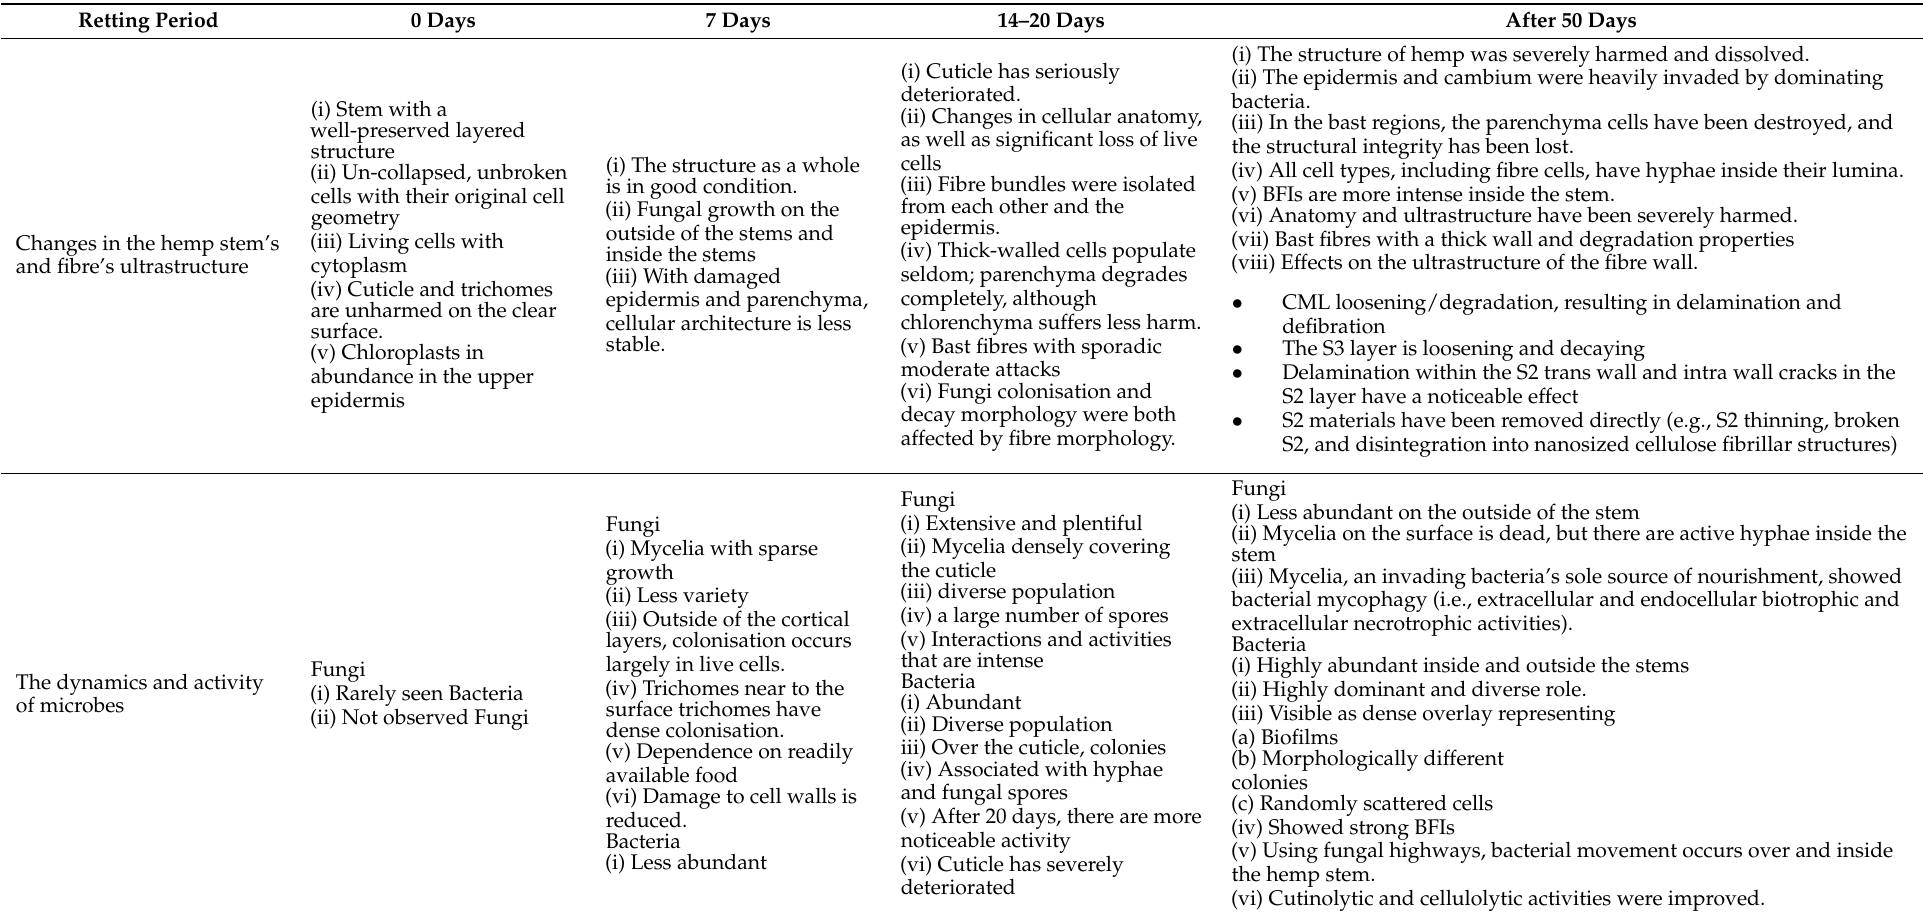
Table 2. Highlights of ultrastructural changes on hemp stems and fibres associated with microbial activity during the retting process [29]. Retting